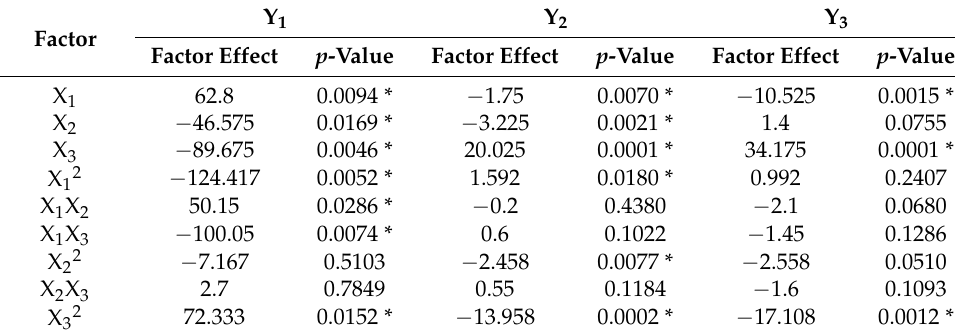
Table 3. Estimated effects of factors associated with p -values for responses (Y 1 –Y 3 ).